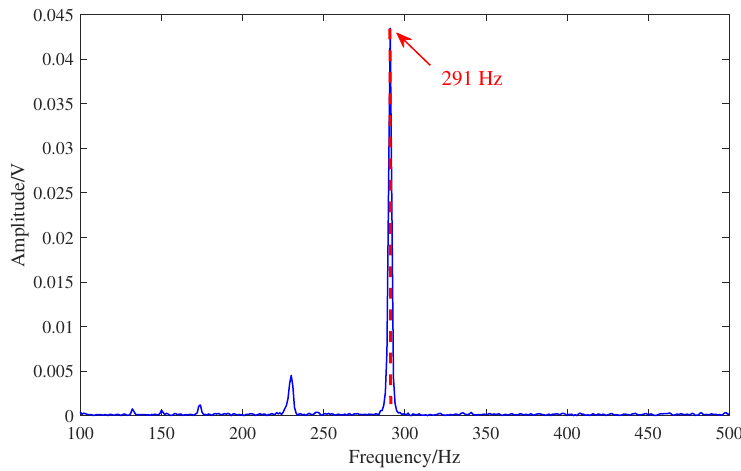
Figure 12. Natural frequency test results.